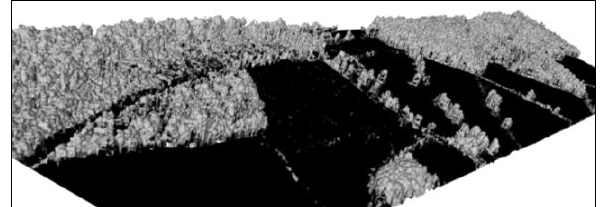
Figure 8. 3D tree coverage model A Naïve Bayesian classifier using a multi-variance Gaussian model is applied for distinguishing tree covered areas from the ground. The main idea is for each pixel/column to find the class that is more likely to belong to (Tree or